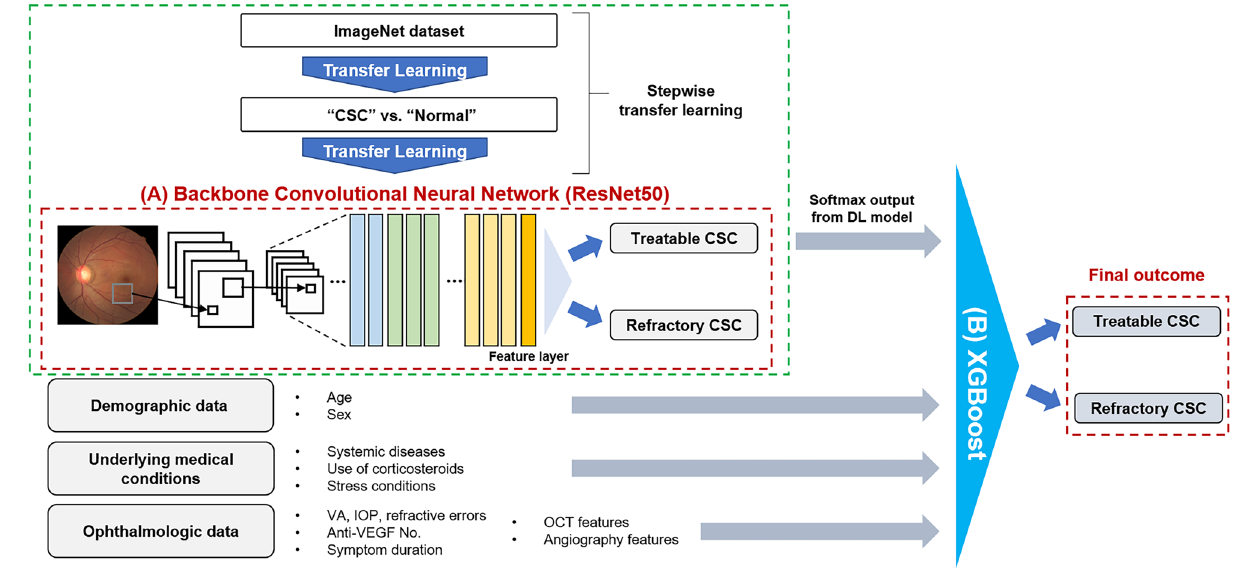
Figure 6. Schematic diagram explaining the structure of DeepPDT-Net: the backbone ResNet50 model for deep transfer learning from initial fundus photographs (FPs) and the XGBoost model for concatenation of the extracted deep FP features with other multimodal clinical